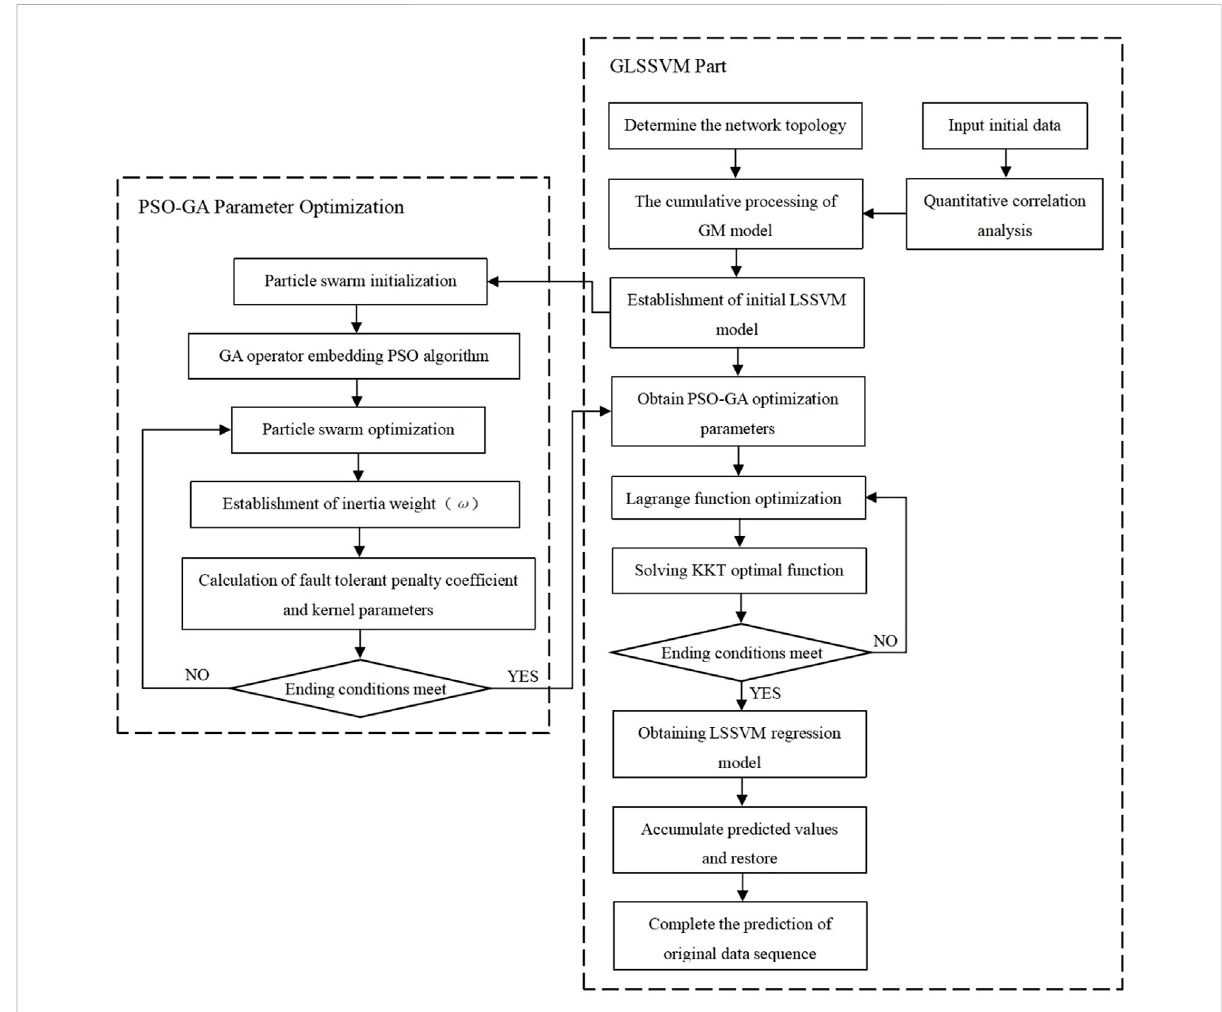
FIGURE 5 Prediction process of GLSSVM-PSO-GA prediction model.